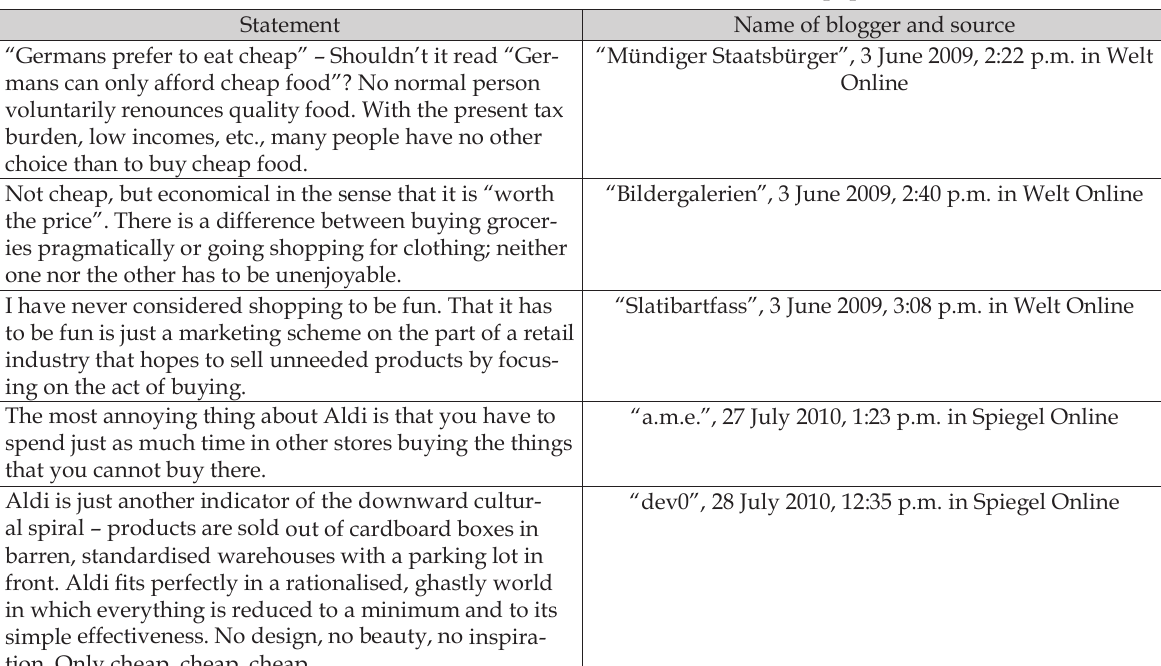
Fig. 4. Accessibility of discounters by car in the rural area of Ascheffel, the province of Schleswig-Holstein, Germany. Source: Nielsen Company 2011, content prepared by S. Schnitker (GIS), cartographic elaboration by P. Sinuraya. Table 2. Comments on discount stores in online